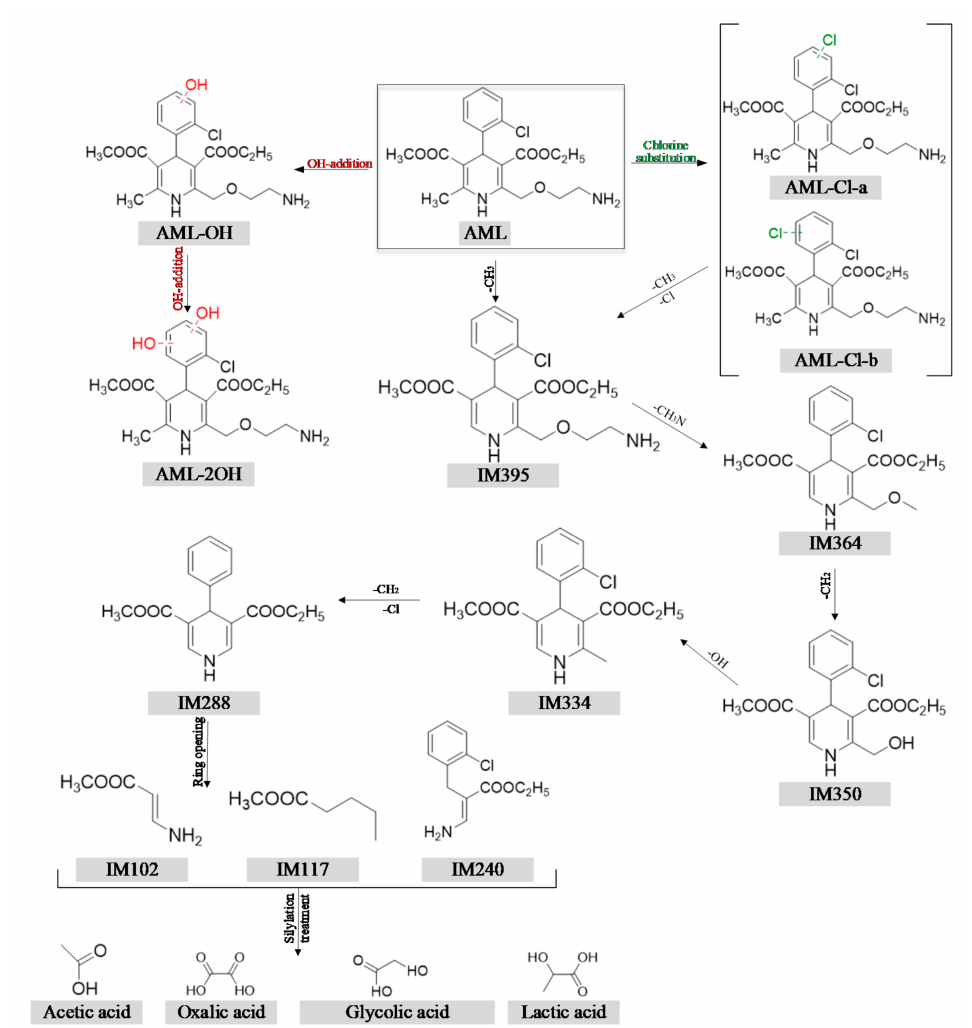
Figure 9. Reaction pathway of AML degradation by the UV / chlorine